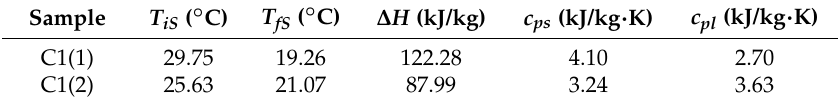
Figure 3. Sample C1. Enthalpy vs. temperature curves with variation of the modality of preparation. Table 4. Thermal properties of the first sample C1 prepared by means of the modalities (1) and (2).